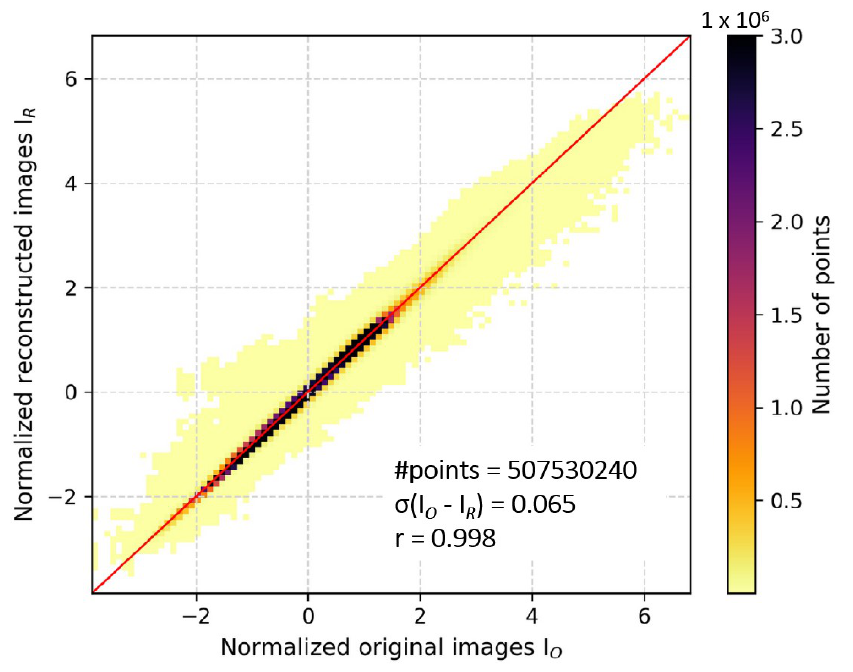
Figure 9. Bi-dimensional (2D) histogram and correlation between the normalized original images (x-axis) and their reconstruction by the autoencoder (y-axis). Images are from the validation set.